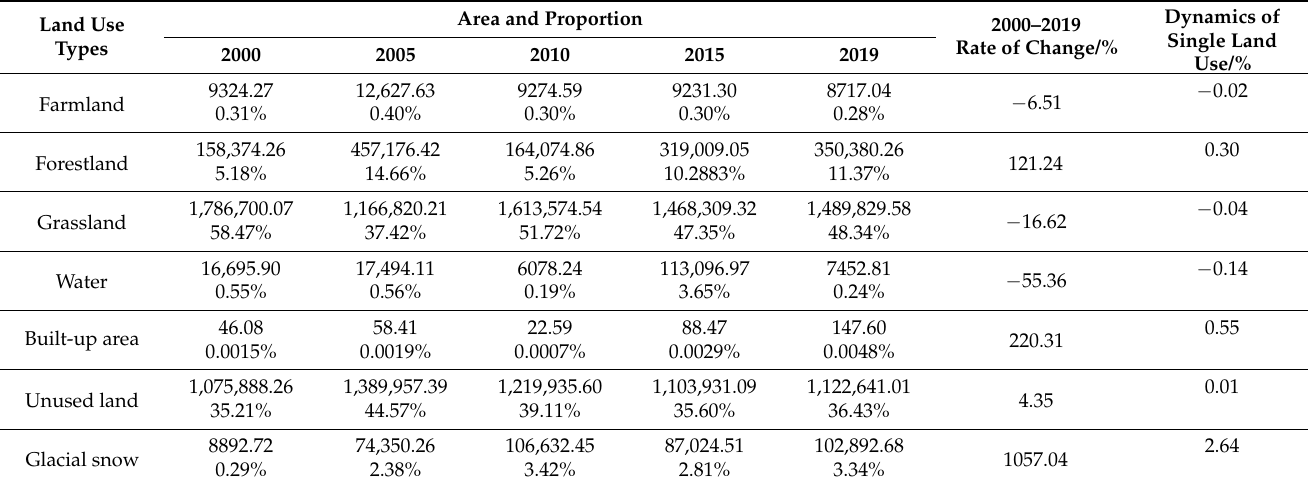
Table 2. Changes in land use area and proportion of Qilian Mountain National Park (Gansu Area) from 2000 to 2019 (units: hm 2 , %).